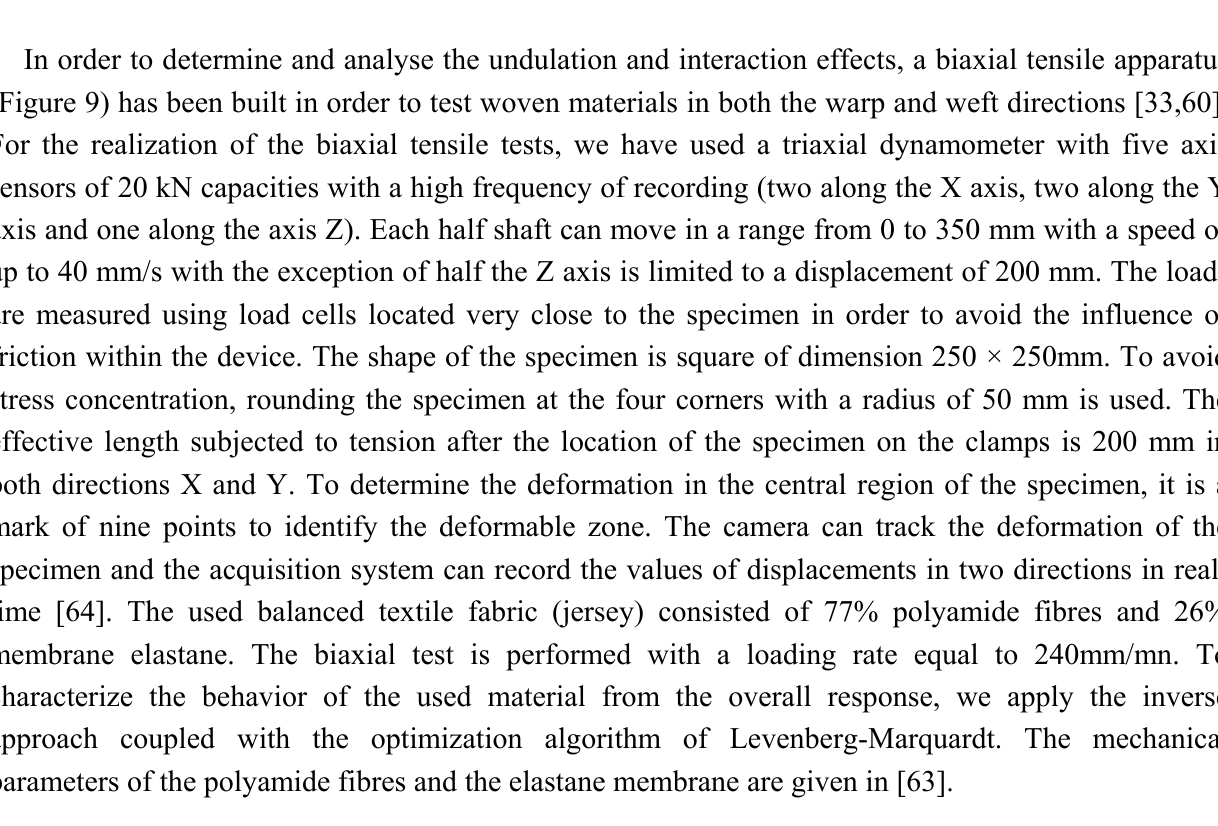
Figure 9. Device for a biaxial tensile test on cross fabric